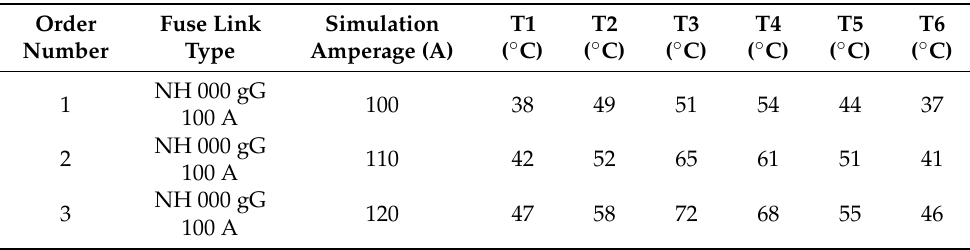
Table 4. Results for amperages of 100, 110 and 120 A for fuse link type NH000 gG 100 A. Results were obtained after 7200